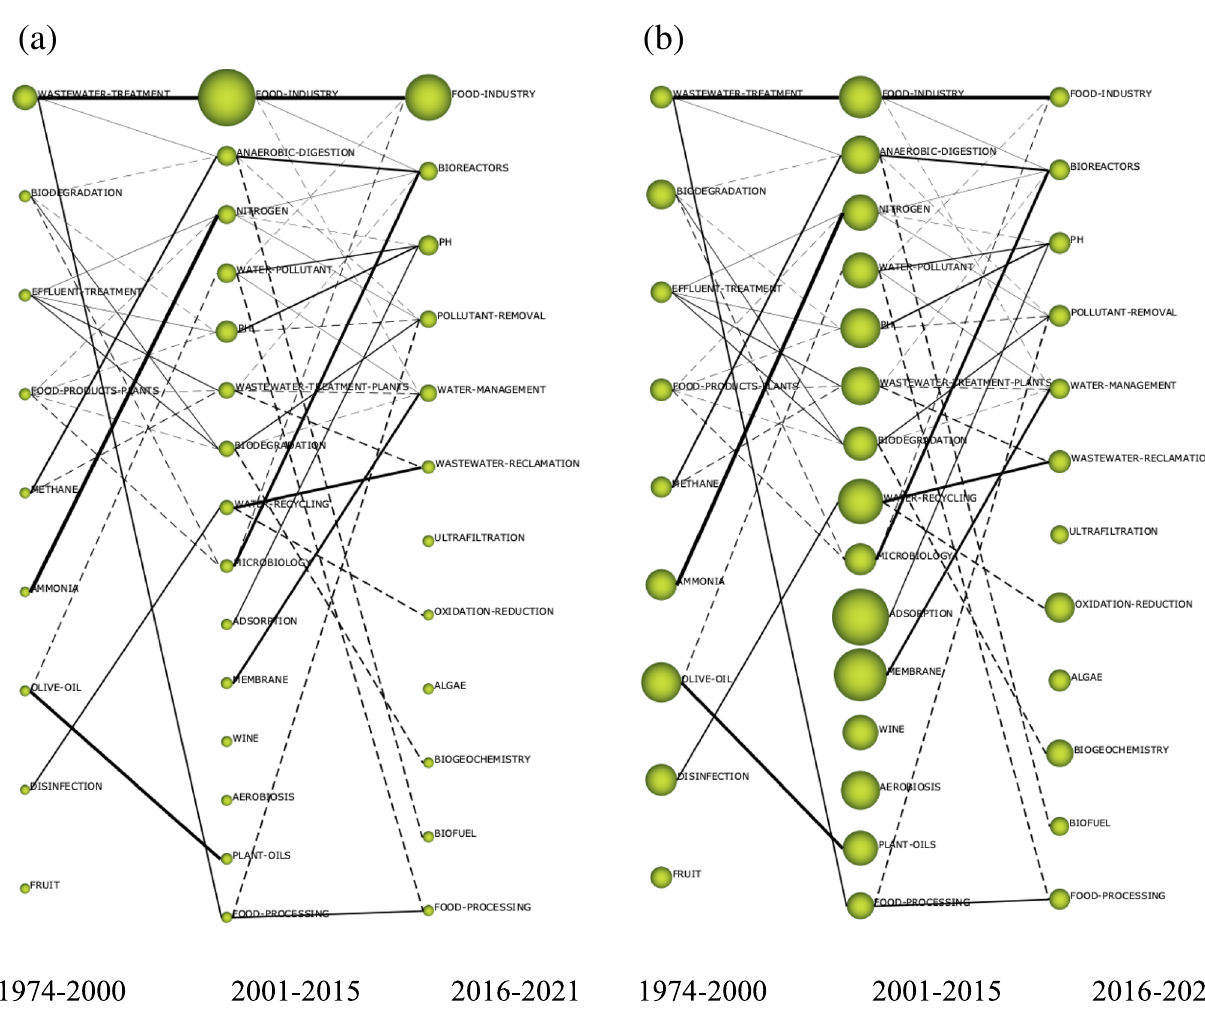
Fig. 8 Thematic evolution map of the research field in terms of ( a ) number of documents and ( b ) average